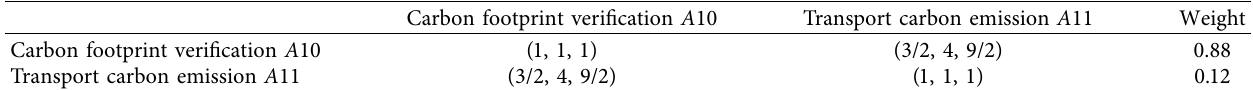
Table 6: Fuzzy judgment matrix of product carbon emission.